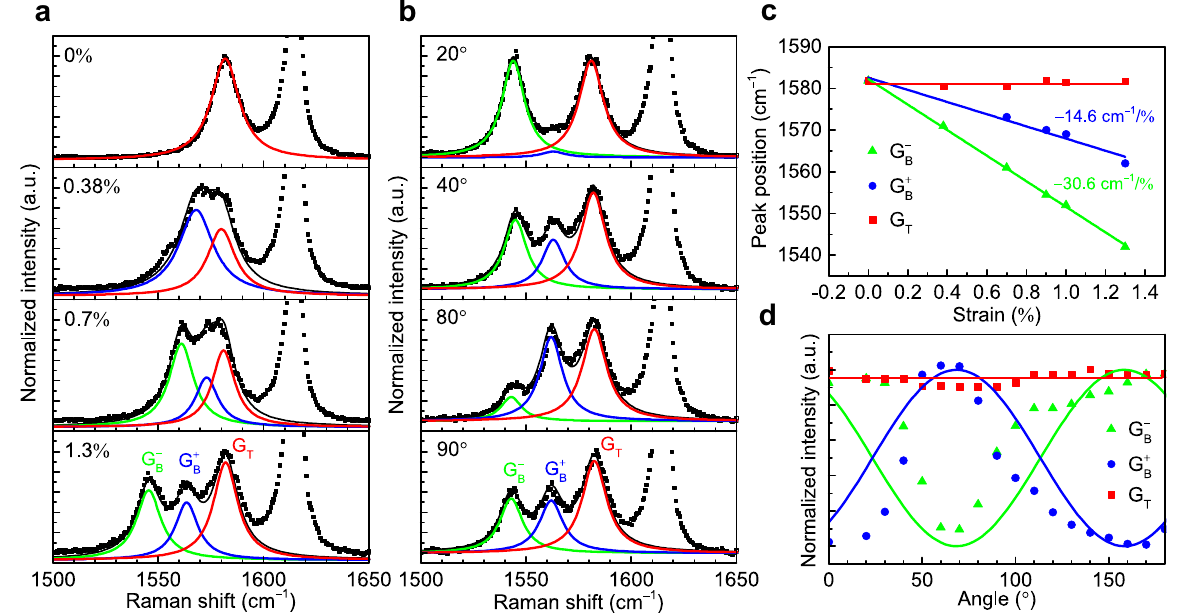
Figure 2. Verification of heterostrain in the TBG device via Raman spectroscopy. ( a ) Raman spectra measured with different bending radii, showing triple peaks arising from the heterostrained TBG device. ( b ) Polarization- resolved Raman spectra showing the intensity-modulated G and G peaks and the polarization-insensitive G T peak. Uniaxial strain of 1.3% was applied to bottom graphene. ( c ) The shift of the three G peaks arising from strained bottom and unstrained top graphene layers. ( c ) The intensity of the three G peaks as a function of the rotational angle. Green curve: I G